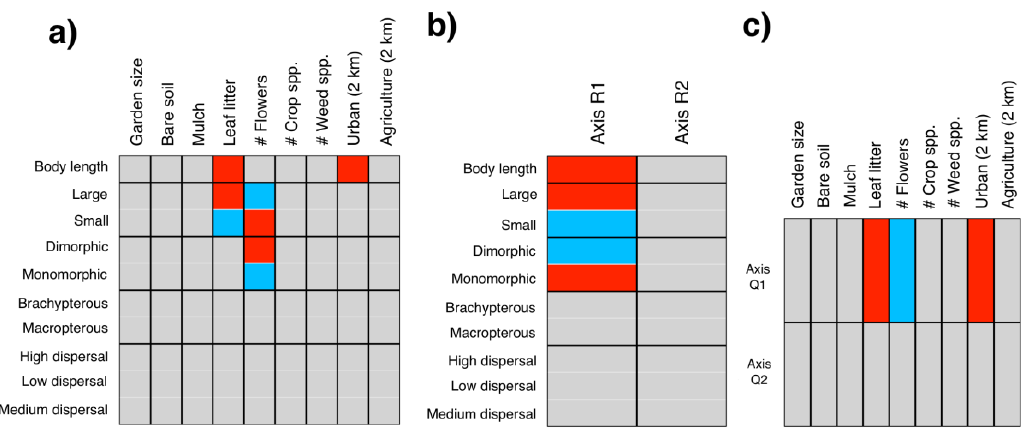
Figure 3. Biplot of fourth corner analysis ( a ) of carabid traits in relation to local and landscape factors. In ( b ) and ( c ), biplot of RLQ analysis of the relationship between the carabid trait axis (Q) in relation to the local and landscape factors axis (R). Red indicates positive and blue indicates negative correlations between factors.